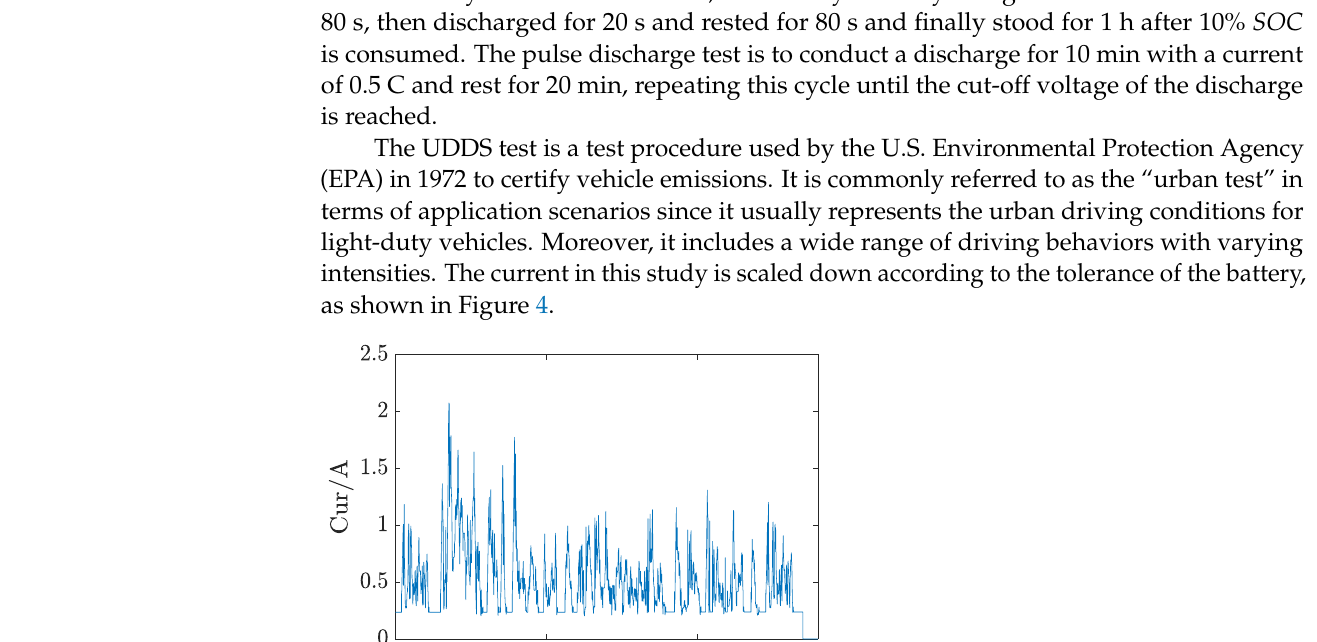
Table 4. The value range of model